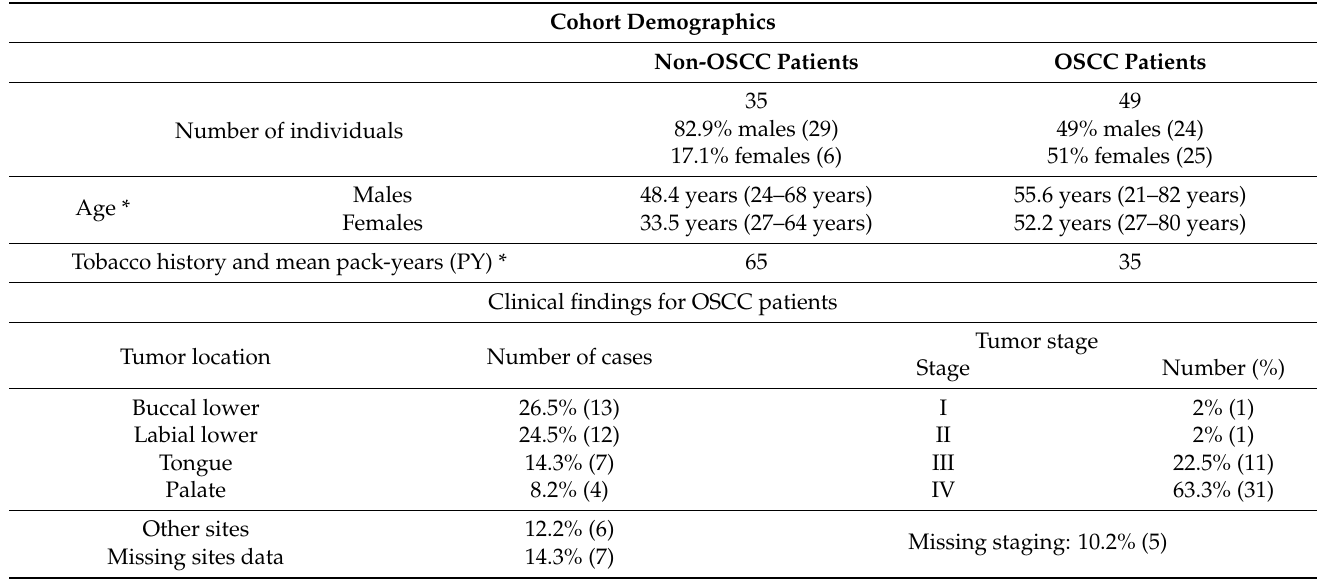
Table 1. Demographic and clinical characteristics of the cohort.